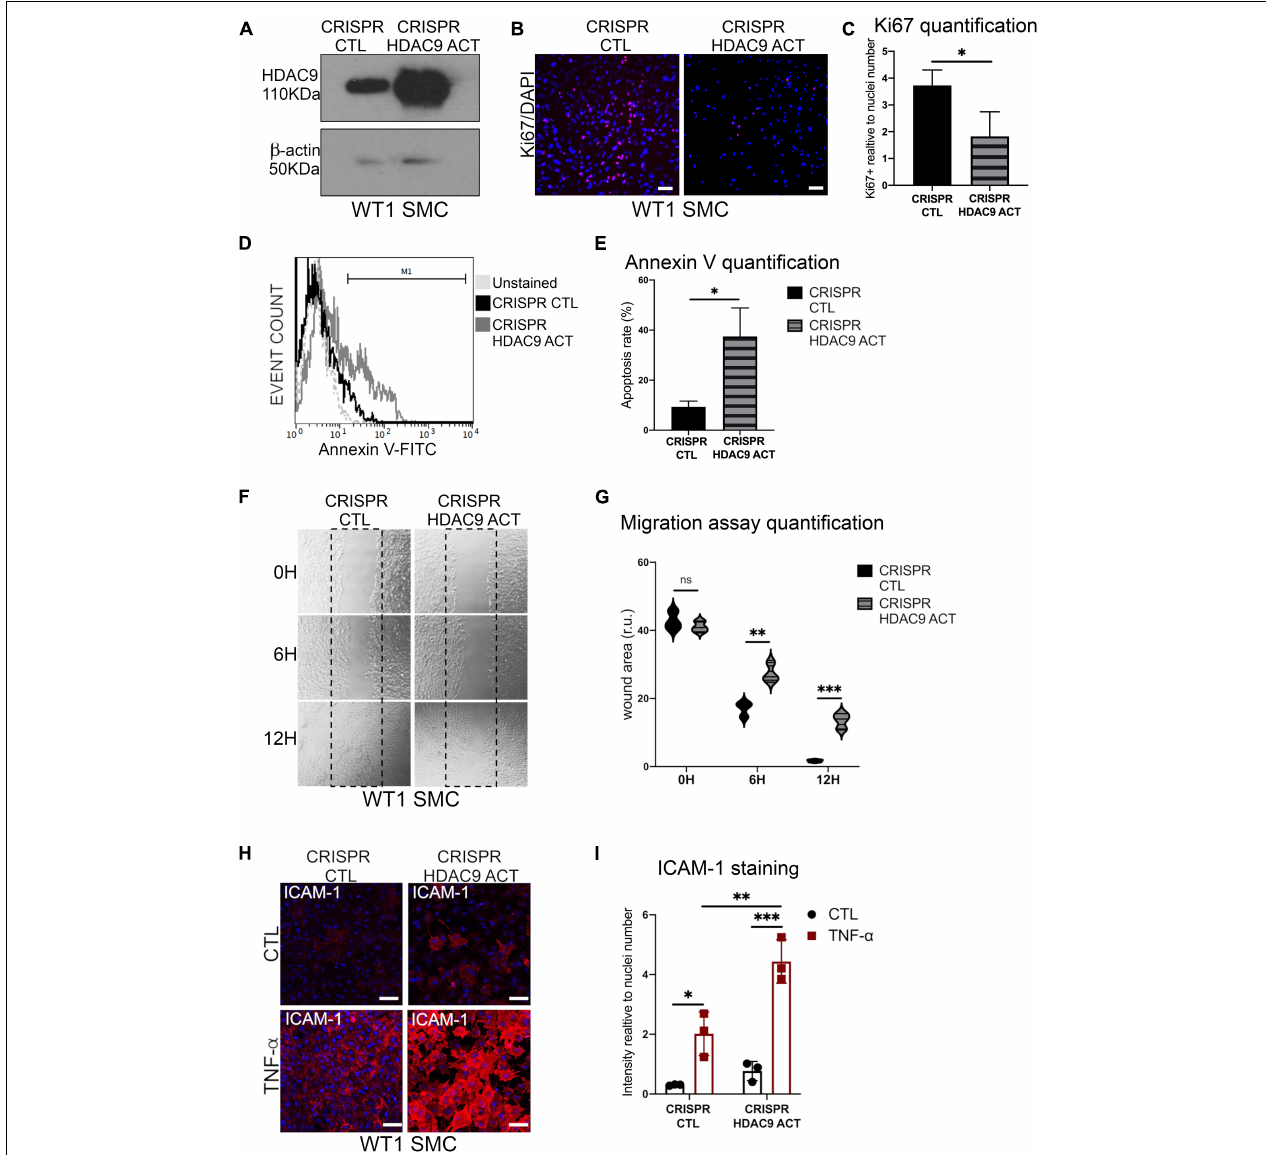
FIGURE 7 | Histone deacetylase 9 overexpression drives SMC phenotypes. (A) Cropped blot of HDAC9 and β -actin in WT1 hiPSC-derived SMC transfected with control CRISPR Plasmid (CRISPR CTL) and HDAC9 CRISPR Activation plasmid (CRISPR HDAC9 ACT). (B) Ki67 proliferation staining in CRISPR activation plasmid transfected control (CRISPR CTL) and HDAC9 (CRISPR HDAC9 ACT) SMC; and (C) quantification of Ki67 staining expressed relative to cells number (nuclei). (D) Flow cytometric analysis of Annexin V (FITC) show percentage gated for in CRISPR CTL (12.9%) and CRISPR HDAC9 ACT (33.6%), SMC and unstained (dotted lines) and (E) Annexin V staining quantification. (F) Representative images of scratch wound assays for CRISPR activation transfected control (CRISPR CTL) and HDAC9 (CRISPR HDAC9 ACT) WT1 hiPSC-derived SMC at the indicated time points (0, 6, and 12 h) and (G) quantification of the wound areas. (H) Cell surface ICAM-1 immunostaining in CRISPR CTL and CRISPR HDAC9 ACT WT1 SMC control (CTL) and upon TNF- α stimulation for 24 h (TNF- α ), and (I) quantification of ICAM-1 staining relative to cells number (nuclei). Nuclei were stained with DAPI. Scale bar = 100 µ m. The results are presented as means ± SD of three